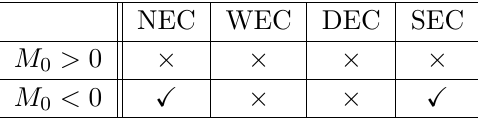
Table 3 . The energy conditions near r = 0 in the spacetime (2.18) with M ( r ) ’ M 0 r 3+ α